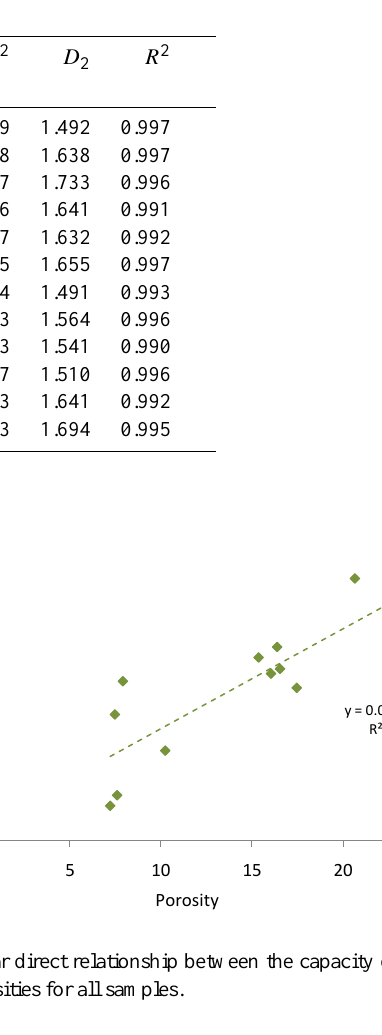
Figure 8. Linear direct relationship between the capacity dimensions D 0 and porosities for all 3